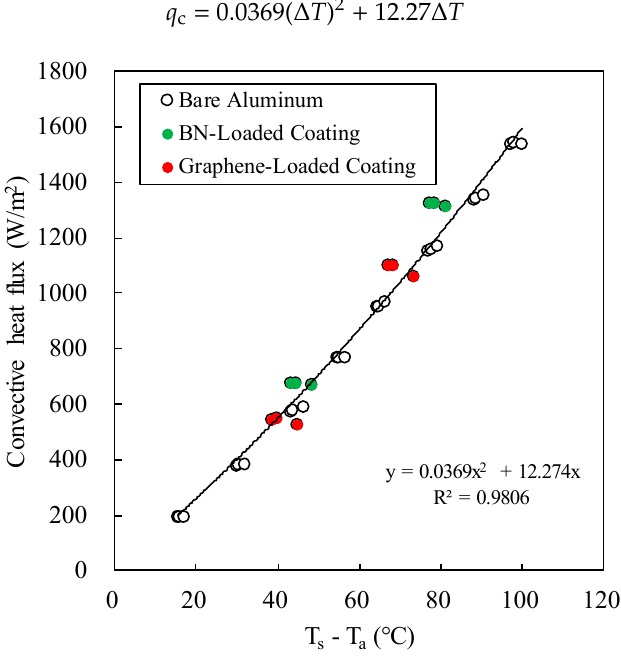
Figure 6. The convective heat fluxes of coated and uncoated aluminum plates under natural convection.